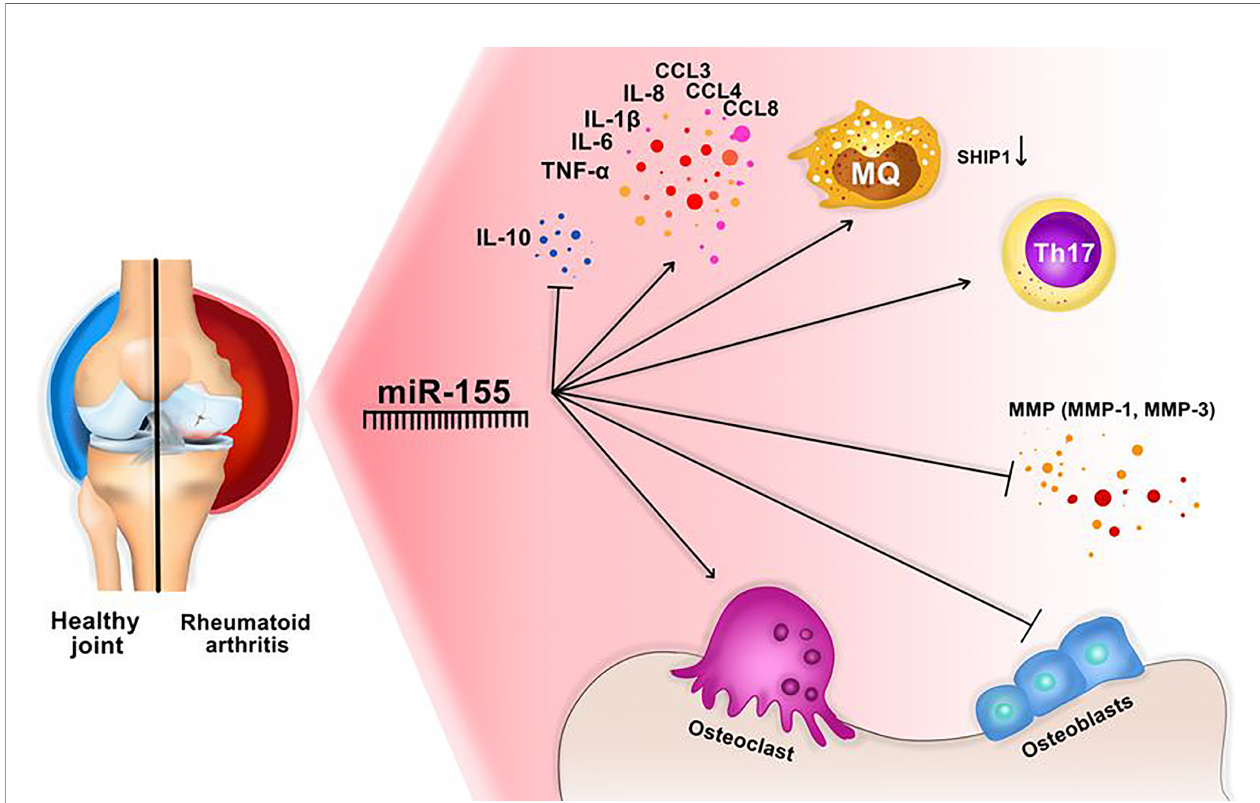
FIGURE 3 | miR-155 might have an important role in RA development. This miRNA activates Osteoclasts activation, Th17 cells, macrophages, and in fl ammatory cytokines, and blocks osteoblast production, and inhibitory cytokines, including IL-10. In addition, MMP production (especially MMP-1 and MMP-3) are decreaced through downregulation of